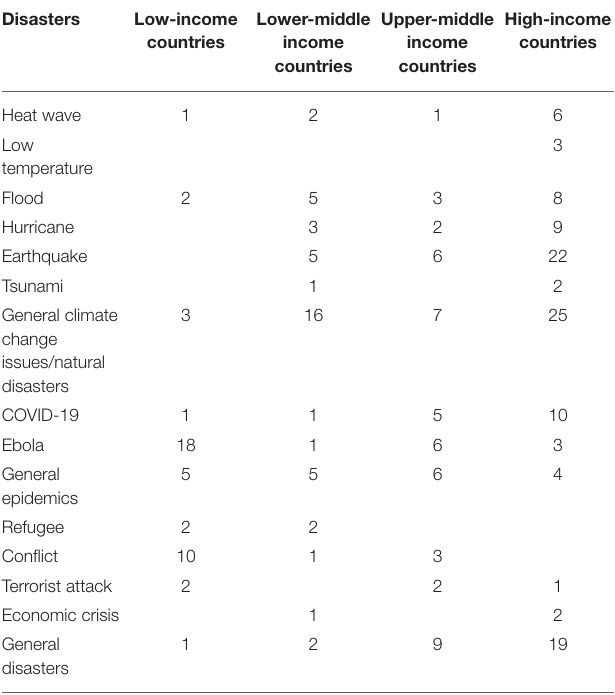
TABLE 1 | Data stratification based on countries’ economic level and concerned